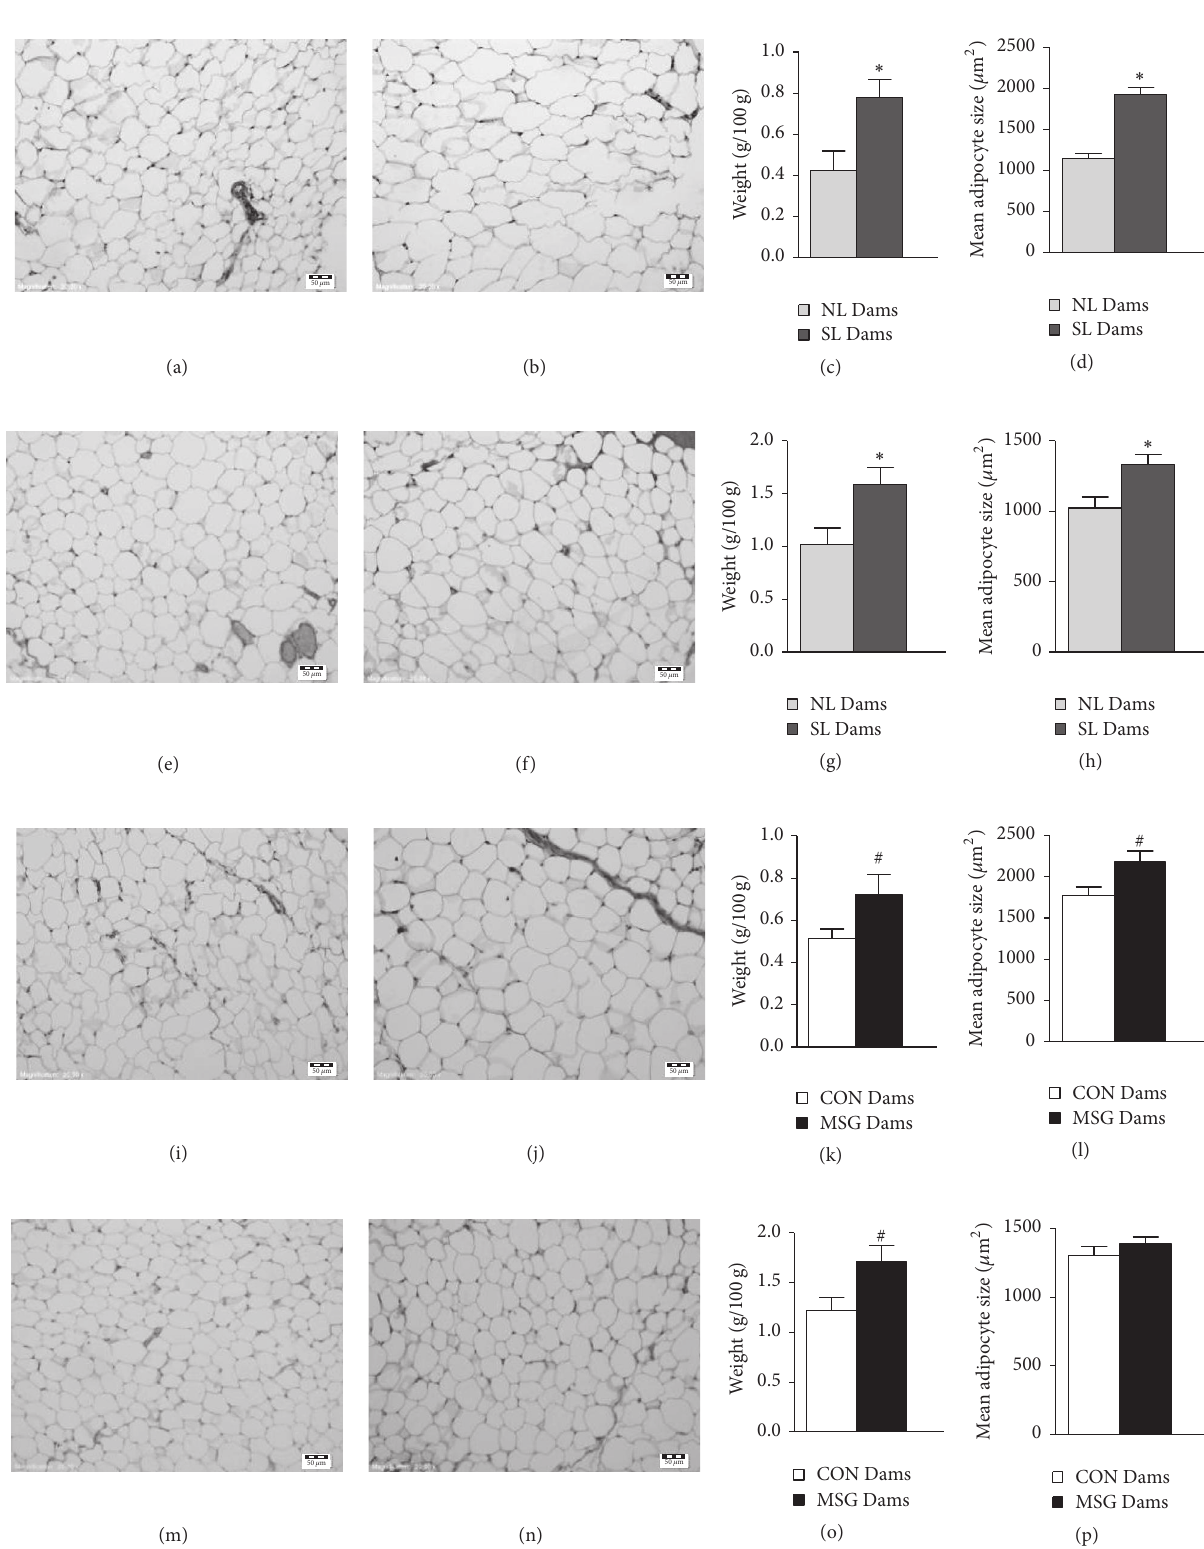
Figure 3: Morphologic adaptations of WAT in dams at 21 days of lactation. Representative photomicrographs (magnification 200x; scale bar, 50 𝜇 m) of H&E-stained sections of retroperitoneal, (a) (NL), (b) (SL), (i) (CON), (j) (MSG) and ovarian adipose tissue, (e) (NL), (f) (SL), (m) (CON), and (n) (MSG). The quantification of mean adipocyte areas (mean ± SEM) is depicted in (d), (h), (l), and (p). Sections were evaluated from 𝑛 = 3 dams/group and three image fields per section. Retroperitoneal fat content is represented in (c) (NL, SL) and (k) (CON, MSG) and ovarian fat content is represented in (g) (NL, SL) and (o) (CON, MSG). Symbols above the bars represent statistical differences in Student’s 𝑡 -test ( 𝑝 < 0.05 ). ∗ NL Dams versus SL Dams; # CON Dams versus MSG